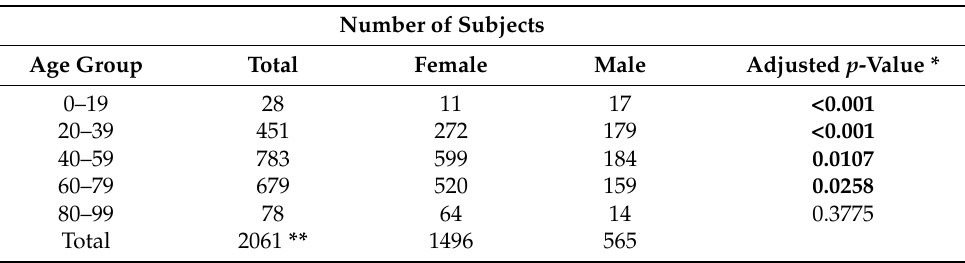
Table 2. Subject demographics: age distribution, also sex stratified, with test for age group proportion being different in the two sex groups (Chi-square test).